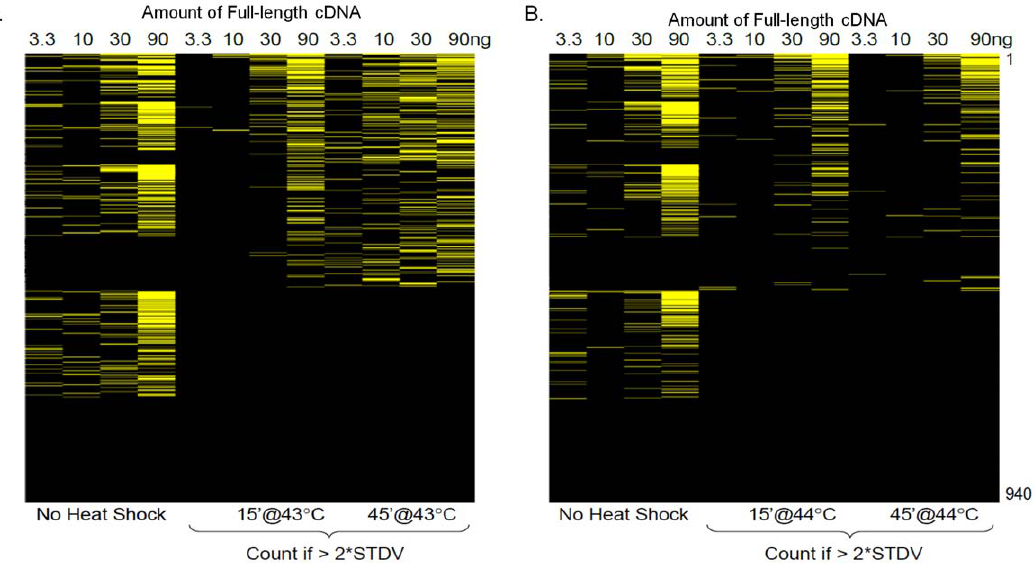
Figure 2. A heat map showing the results from the secondary screen for hyper-activation of the heat shock response. An active subset of full-length genes from the primary screen was transfected at multiple concentrations and subjected to two different heat shock temperatures, (A) 43 u C and (B) 44 u C. The degree of hyper-activation of the response is represented by the intensity of the yellow color. A positive hit is scored if the full-length gene activates the normalized HSP70B reporter by more than two standard deviations above the mean of the negative control (pCMV-Sport6 Empty). The response curve under non-heat shock conditions was monitored but not included in the calculation of the score.